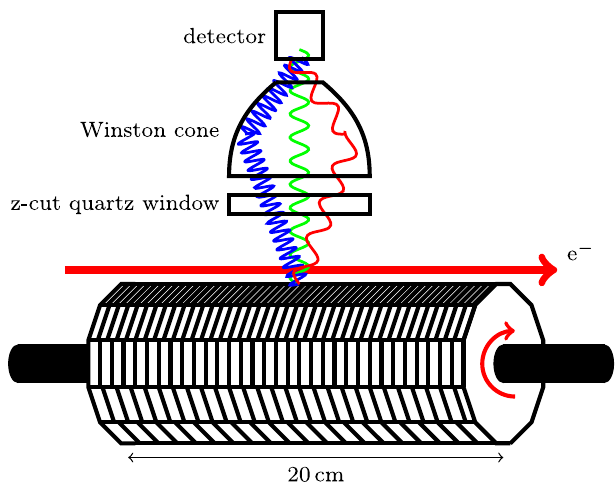
FIG. 5. Setup of the experiment. Multiple gratings can be placed next to the electron beam. The central observation angle is η ¼ ζ ¼ 0 ° with an angular spread of (cid:3) 2 . 1 °. The generated THz radiation with a power of some pW to 30 nW is observed with a bolometer cooled down to 4.2 K.